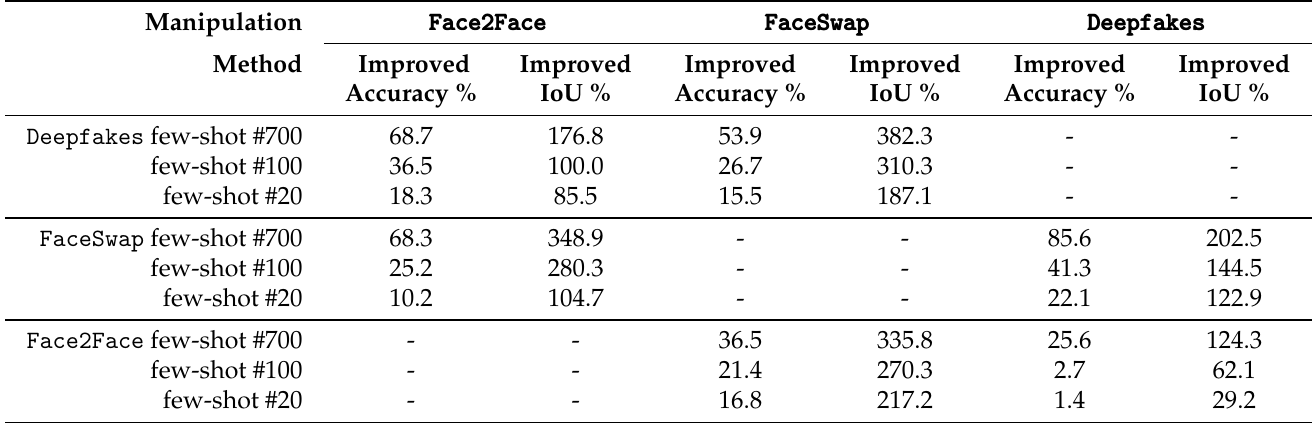
Table 6. Improvement in few-shot learning for detecting C23 crop images altered by Face2Face , FaceSwap , and Deepfakes manipulation methods with difference-based models.